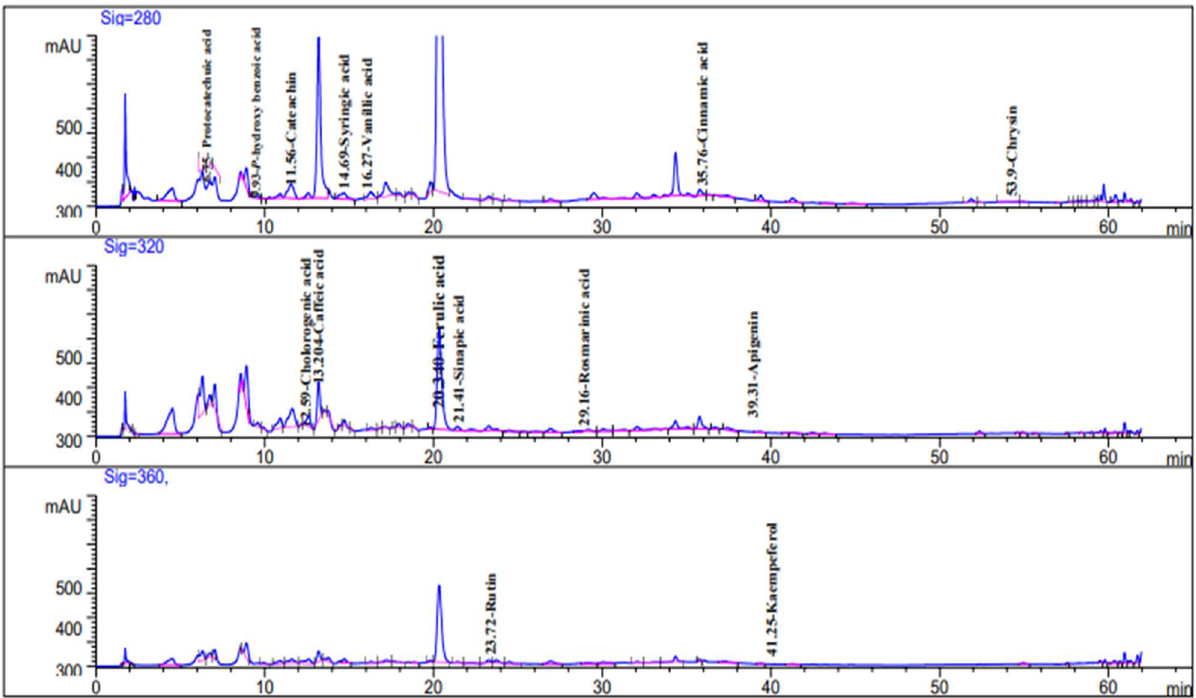
Figure 1. HPLC chromatogram of phenolic compounds (standard mixture).